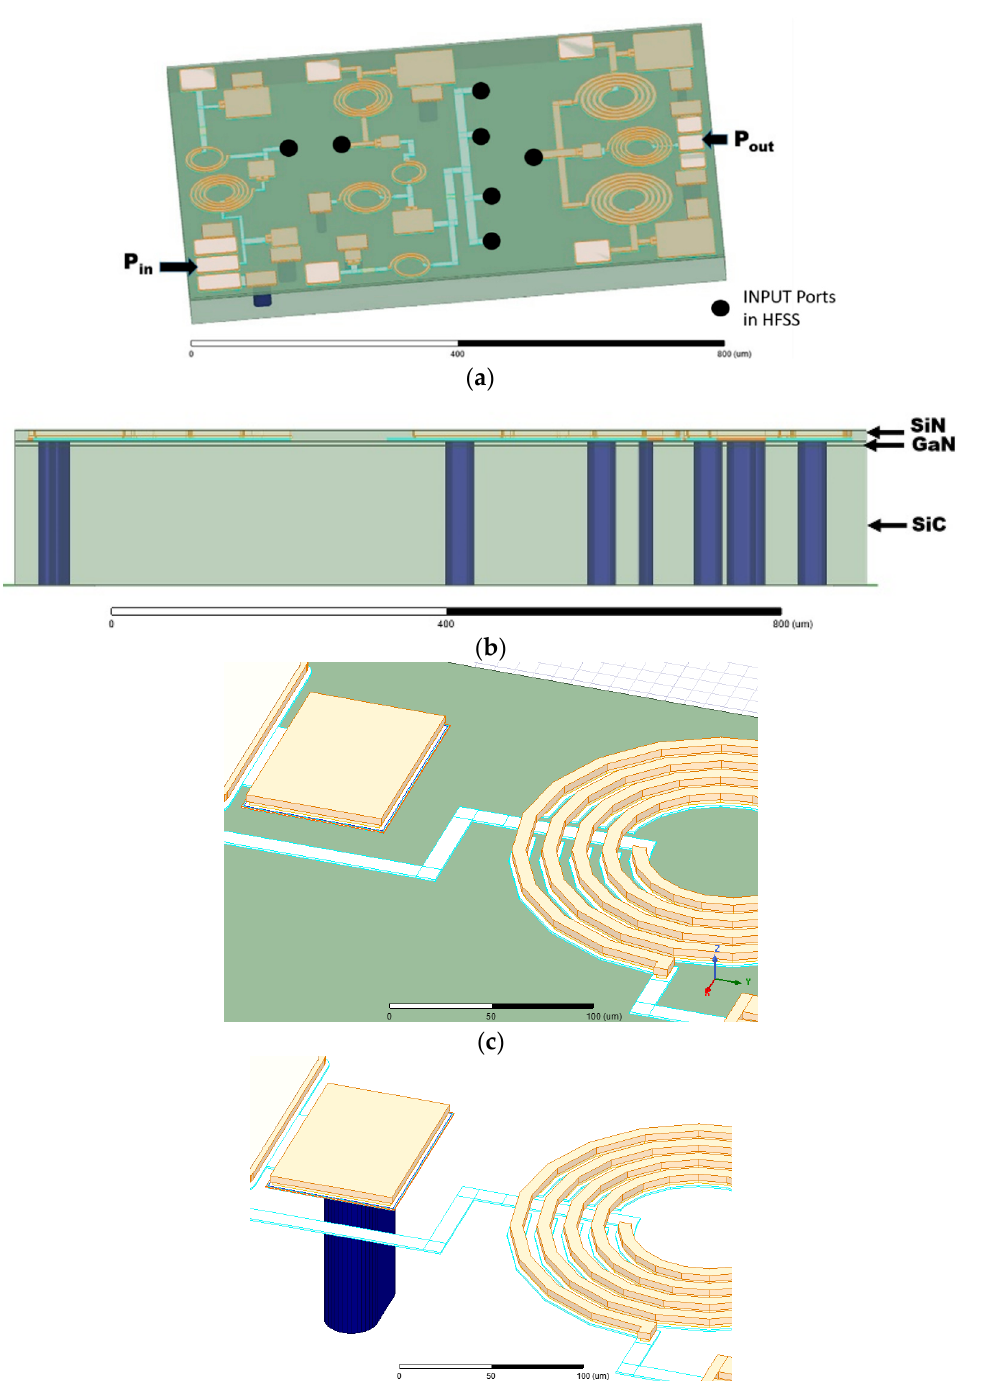
Figure 3. Flow chart of the methodology followed for simulation [28]. ADS, advanced design system; HFSS, high frequency structure simulator.